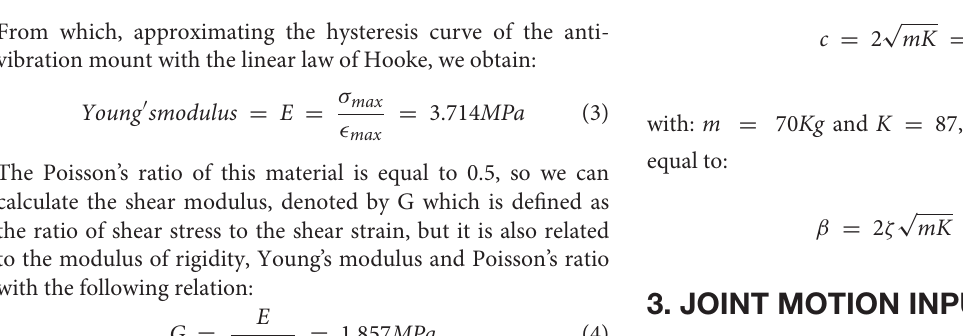
From which, approximating the hysteresis curve of the